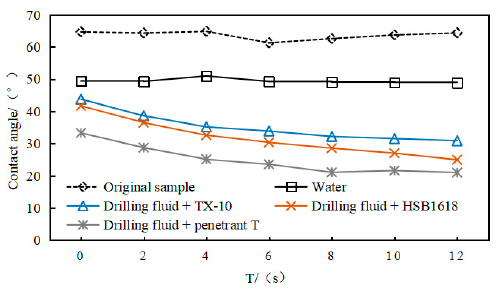
Figure 10. The contact angle variation of solid-free drilling fluid to sample. Figure 11. The contact angle of ( a ) original sample and sample soaked by different drilling fluids ( b ) water, ( c ) basic fluid + 0.10% TX-10, ( d ) basic fluid + 0.10%HSB1618 and ( e ) basic fluid + 0.10 penetrant T.